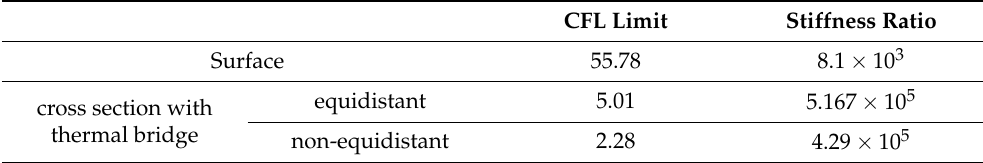
Table 6. The CFL limit and the stiffness ratio quantities for the different